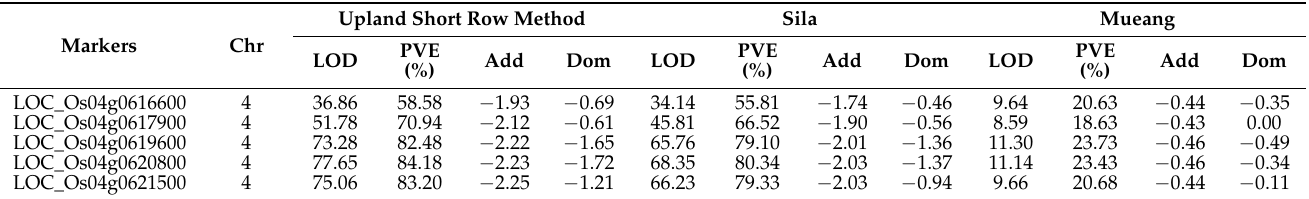
Table 4. Single marker analysis of the five markers, LOC_Os04g0616600 , LOC_Os04g0617900 ( OsGLP4- 1 ), LOC_Os04g0619600 ( OsRLCK161 ), LOC_Os04g0620800 ( Pi63 ), and LOC_ Os04g0621500 , and BL resistance of the F 6 RIL